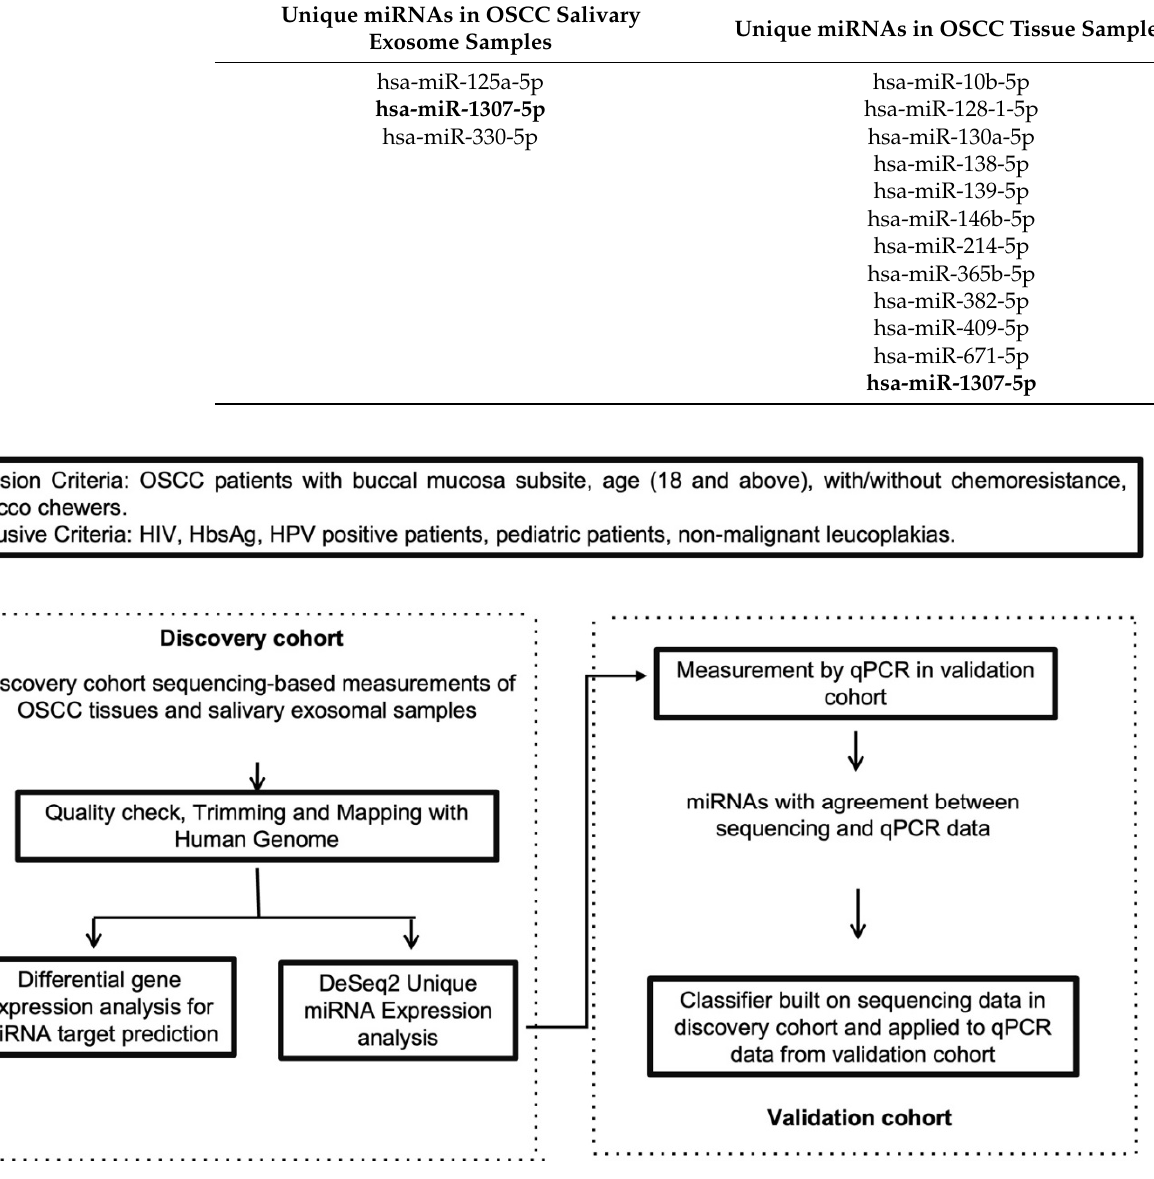
Table A1. List of miRNAs expressed exclusively in OSCC salivary exosome samples and tissue samples.